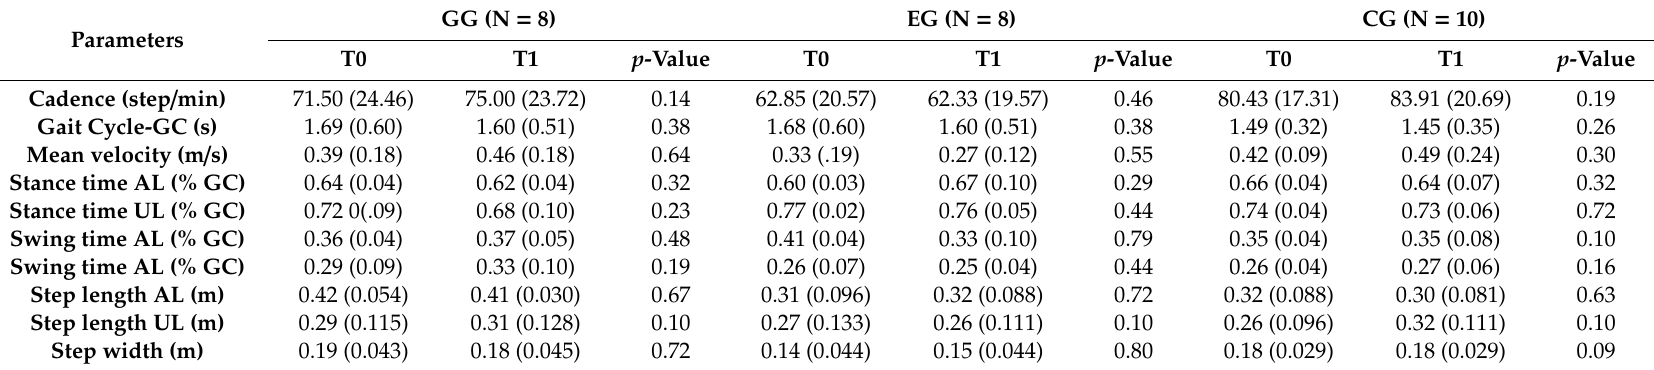
Table 3. Spatio-temporal gait parameters at the beginning (T0) and at the end (T1) of the gait treatment for all groups and the corresponding p -values.